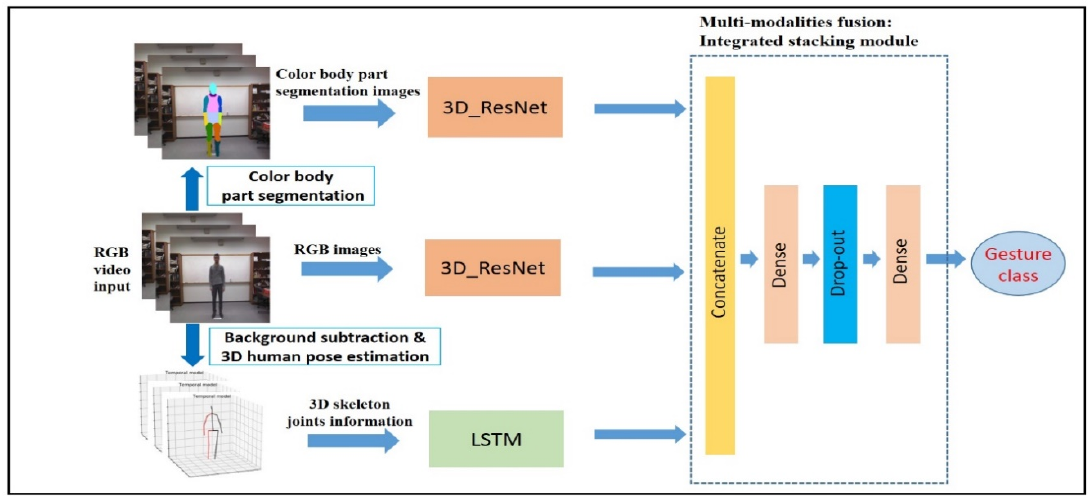
Figure 3. The proposed approach. This algorithm consists of three subnetworks and the fusion